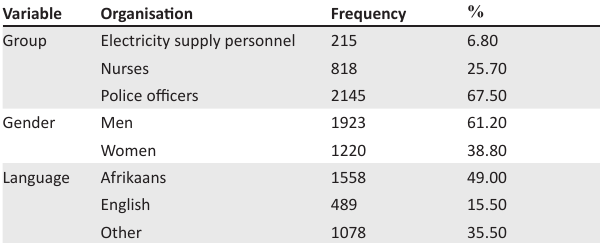
TABLE 1: Characteristics of the participants ( N =